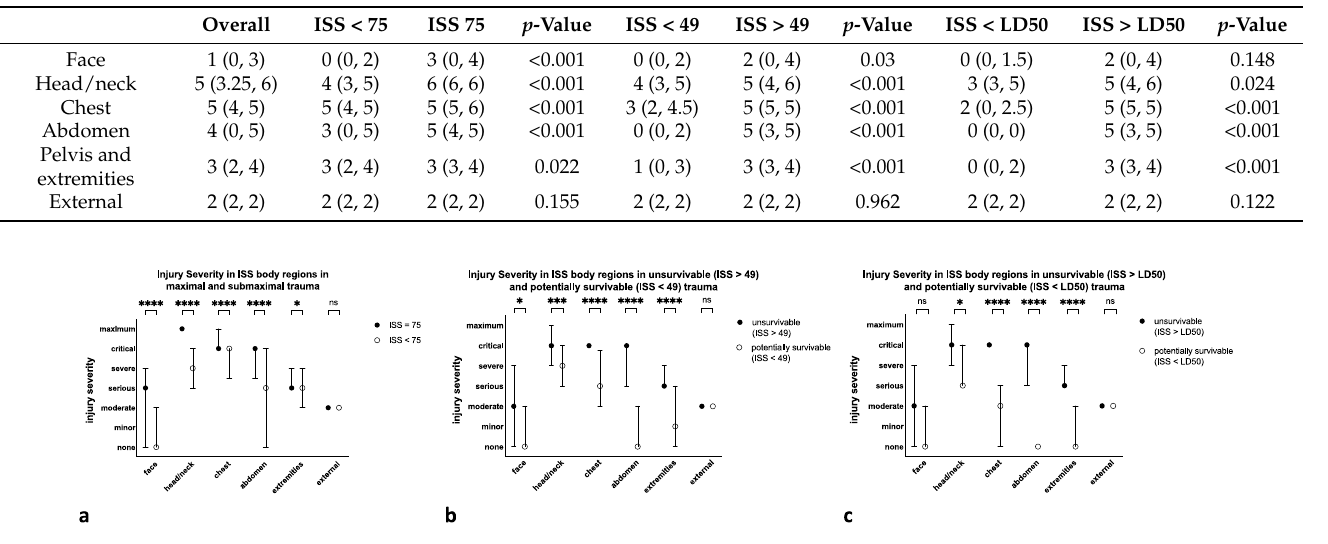
Table 4. Means (SD, IQR) of total ISS and of injury severity to the respective body region.